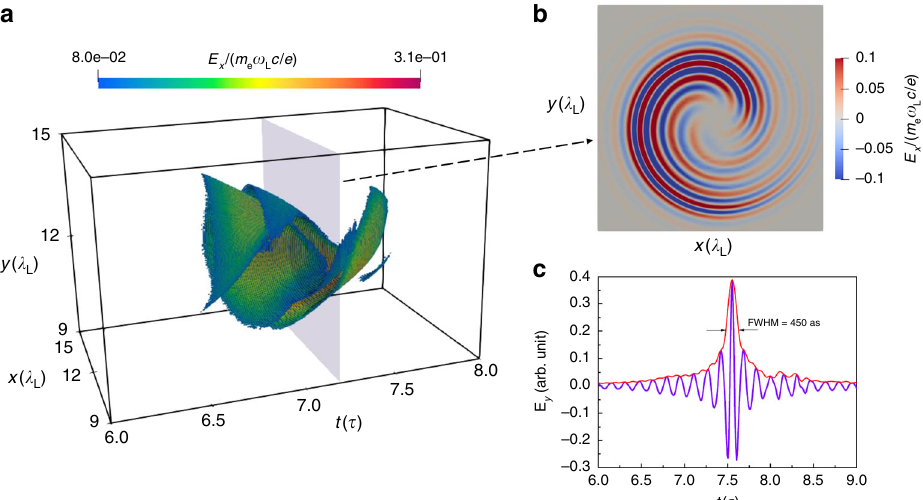
. The fi eld is fi ltered from the 6th to the x ω c = e ð(cid:3) 4 : 0 ´ 10 12 Vm (cid:2) 1 Þ . b The cross section is normalized by m x e L